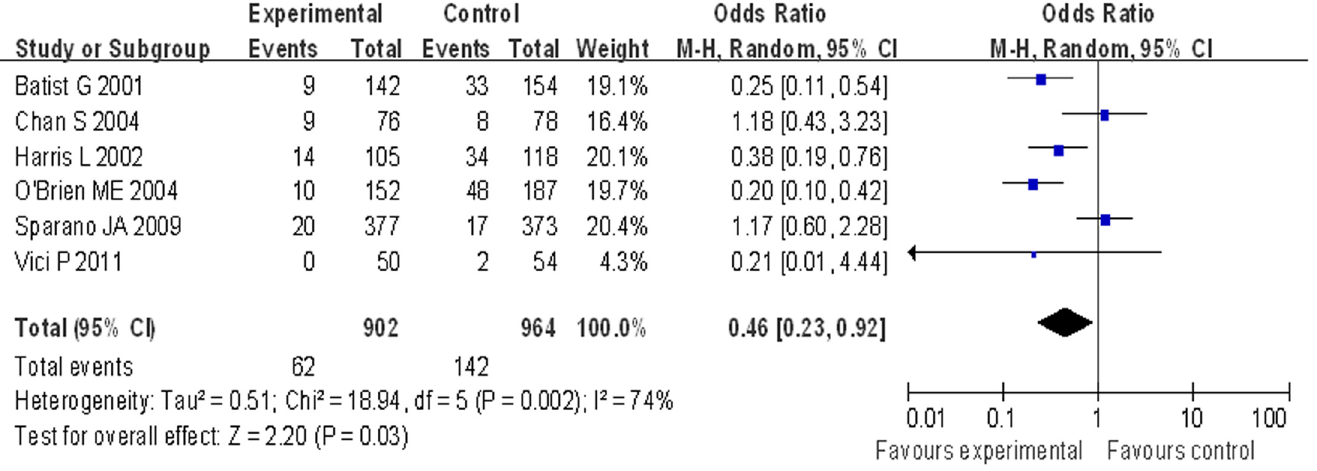
Fig 5. Forest plot of cardiotoxicity comparison between two